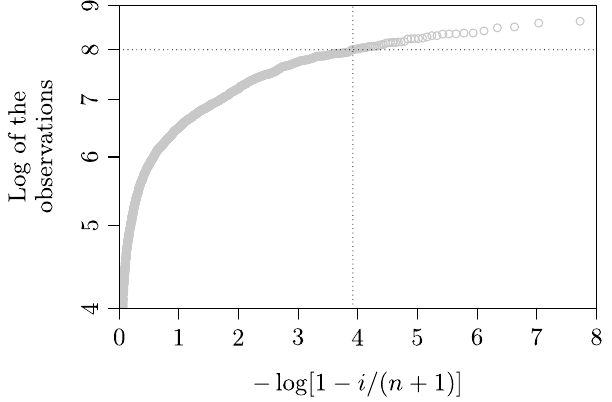
Figure 3: Pareto quantile plot on the same day of the week increases in peak electricity demand. The posterior density of η is given in Figure 4. The mode of the posterior density is an estimate of η . In this study ˆ η = 0 . 1909 is used. The empirical cumulative distribution function ( cdf ) and theoretical cdf of the GSP with the estimated parameter value ˆ η = 0 . 1909 are constructed for observations above the threshold and shown in Figure